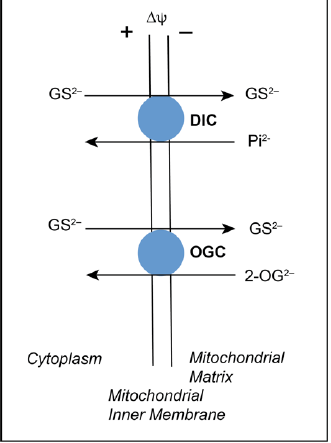
Figure 5. Transport of GSH into renal mitochondria via the dicarboxylate carrier (DIC) and the 2-oxoglutarate carrier (OGC). The scheme illustrates the function of two key inner membrane anion exchange carriers in the movement of GSH from the cytoplasm into the mitochondrial matrix. The DIC catalyzes electroneutral exchange of inorganic phosphate (Pi 2− ) with various organic anions such as malate. The OGC catalyzes the electroneutral exchange of 2-oxoglutarate (2-OG 2– ) with other dicarboxylates such as malate. The GSH molecule is a zwitterion containing a free amino group (positive at physiological pH), two free carboxyl groups (negative at physiological pH), and a sulfhydryl or thiol group (-SH or -S – ). The last group has a pKa of 8.3, so it is extensively depro- tonated at the modestly alkaline pH of the mitochondrial matrix. In this manner, GSH is primarily transported as a dianion in electroneutral exchange for either Pi 2– or 2-OG 2– . Although the focus of this review is on renal mtGSH, many other tissues have simi- larly distinct mtGSH pools, and the function of both the DIC and OGC in transport of GSH from the cytoplasm into mitochondrial matrix has been described in other tissues, includ- ing the liver [42,43], lung [44,45], cardiac myocytes [46], colonic epithelium [47,48], and brain [49,50]. Despite the presence of the DIC, OGC, and GSH in all mitochondria, some tissue-specific differences in the transport processes between renal mitochondria and those from other tissues, such as the liver [43], have been noted. In addition to the obvious role of mtGSH, which is present at millimolar concentra- tions, in maintaining the reduced state of mitochondrial protein thiols, the mtGSH pool is also closely linked to the metabolic state of the renal PT cell. This can be best appreciated by examining the role of 2-OG in mitochondrial intermediary metabolism and the various cellular GSH transport processes (Figure 6). Studies on the transport of GSH across the BLM from the interstitial space/plasma into the renal PT cell have shown that multiple carriers are involved, including Oat3, (possibly) Oat1, and NaC3 [34,51]. 2-OG serves as a co-substrate for all of these carriers, providing the link with the mitochondrial carriers for GSH.